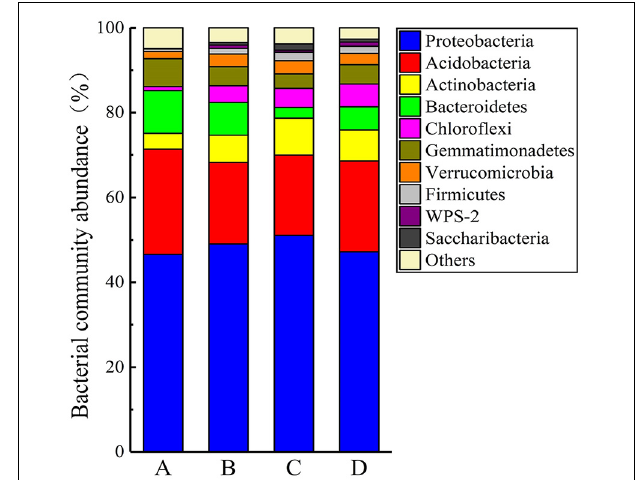
FIGURE 6 | Composition of bacterial communities at the four sampling site, showing the 10 most abundant phyla (with relative abundance > 1% of total reads). Minor phyla (with relative abundances < 1%) were pooled together.